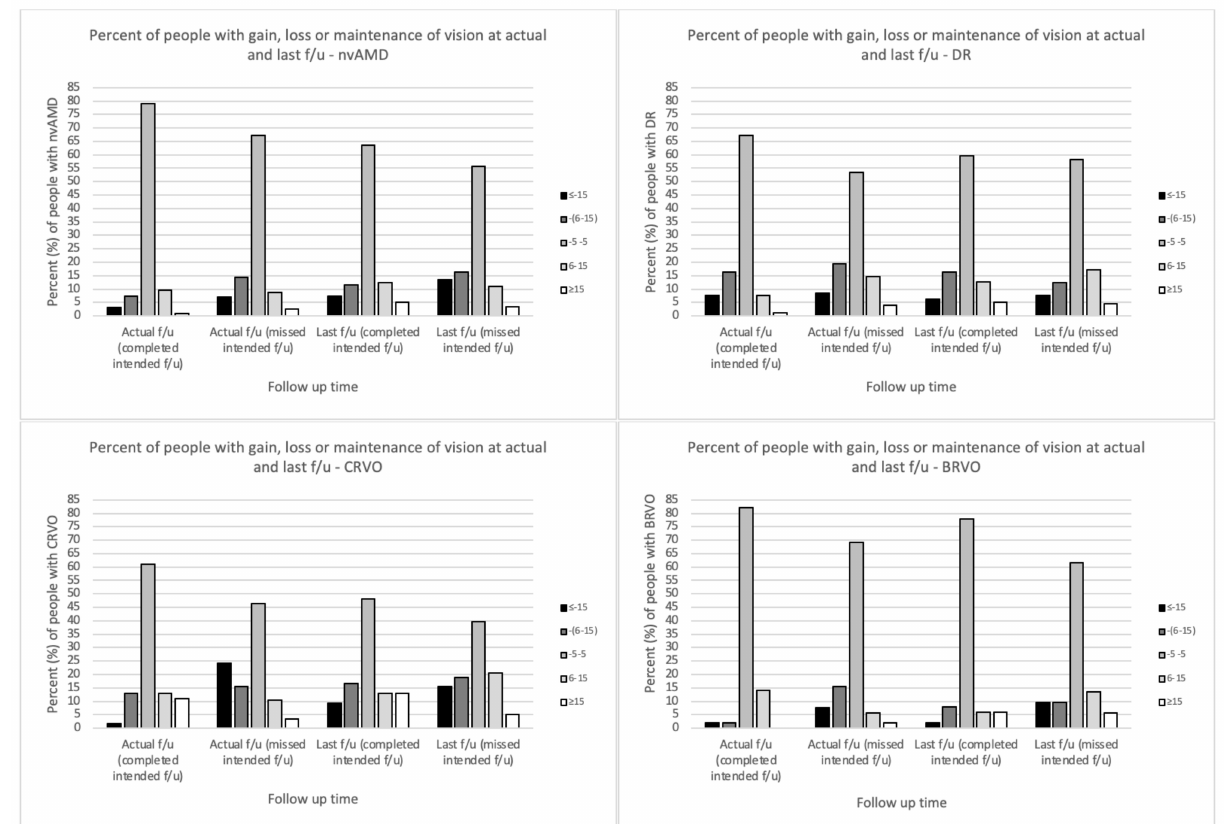
Figure 3. Bar chart depicting the percent of people (completed vs. missed intended f/u) who either maintained, gained, or lost vision (letters) at the intended f/u and last f/u. Abbreviations : nvAMD: neovascular Age-related Macular Degeneration; DR: diabetic retinopathy; CRVO: central retinal vein